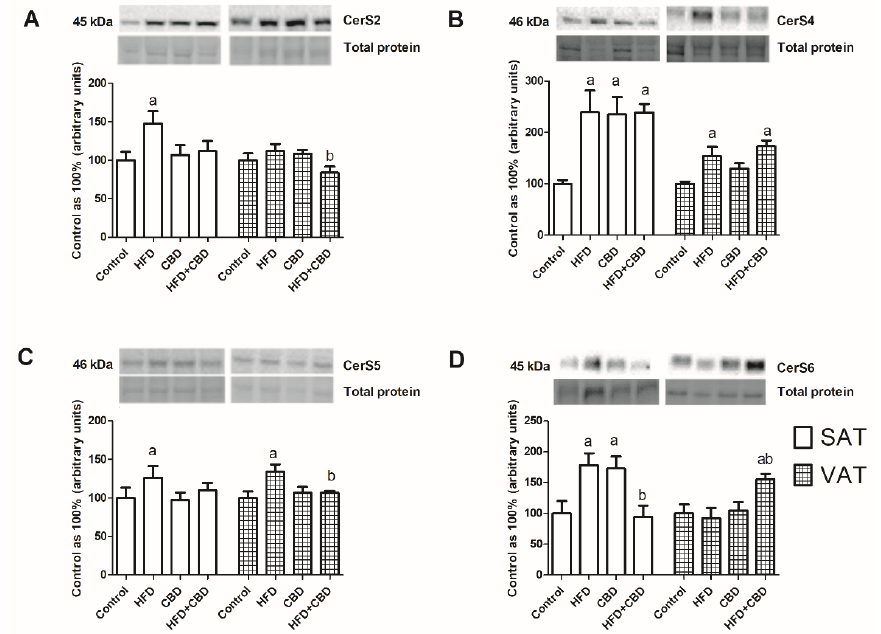
Figure 3. The total expression of proteins from both de novo ceramide synthesis and salvage pathways, e.g., ( A ) ceramide synthase 2 (CerS2), ( B ) ceramide synthase 4 (CerS4), ( C ) ceramide synthase 5 (CerS5), and ( D ) ceramide synthase 6 (CerS6), in the subcutaneous (SAT) and visceral (VAT) adipose tissues of rats fed a standard diet (control) or high-fat diet (HFD) after CBD treatment. The total expression of the above proteins was standardized to the total protein expression, and the control group was set to 100%. The data are expressed as mean values ± SD, n = 6 in each group. a p < 0.05: significant difference: control group vs. experimental group; b p < 0.05: significant difference: HFD vs.